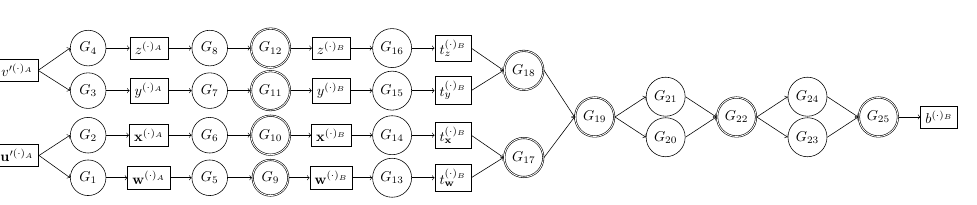
Figure 3: The gadgets considered in the proof of Theorem 2. t -NI gadgets are depicted with a single circle, t -SNI gadgets are depicted with a double